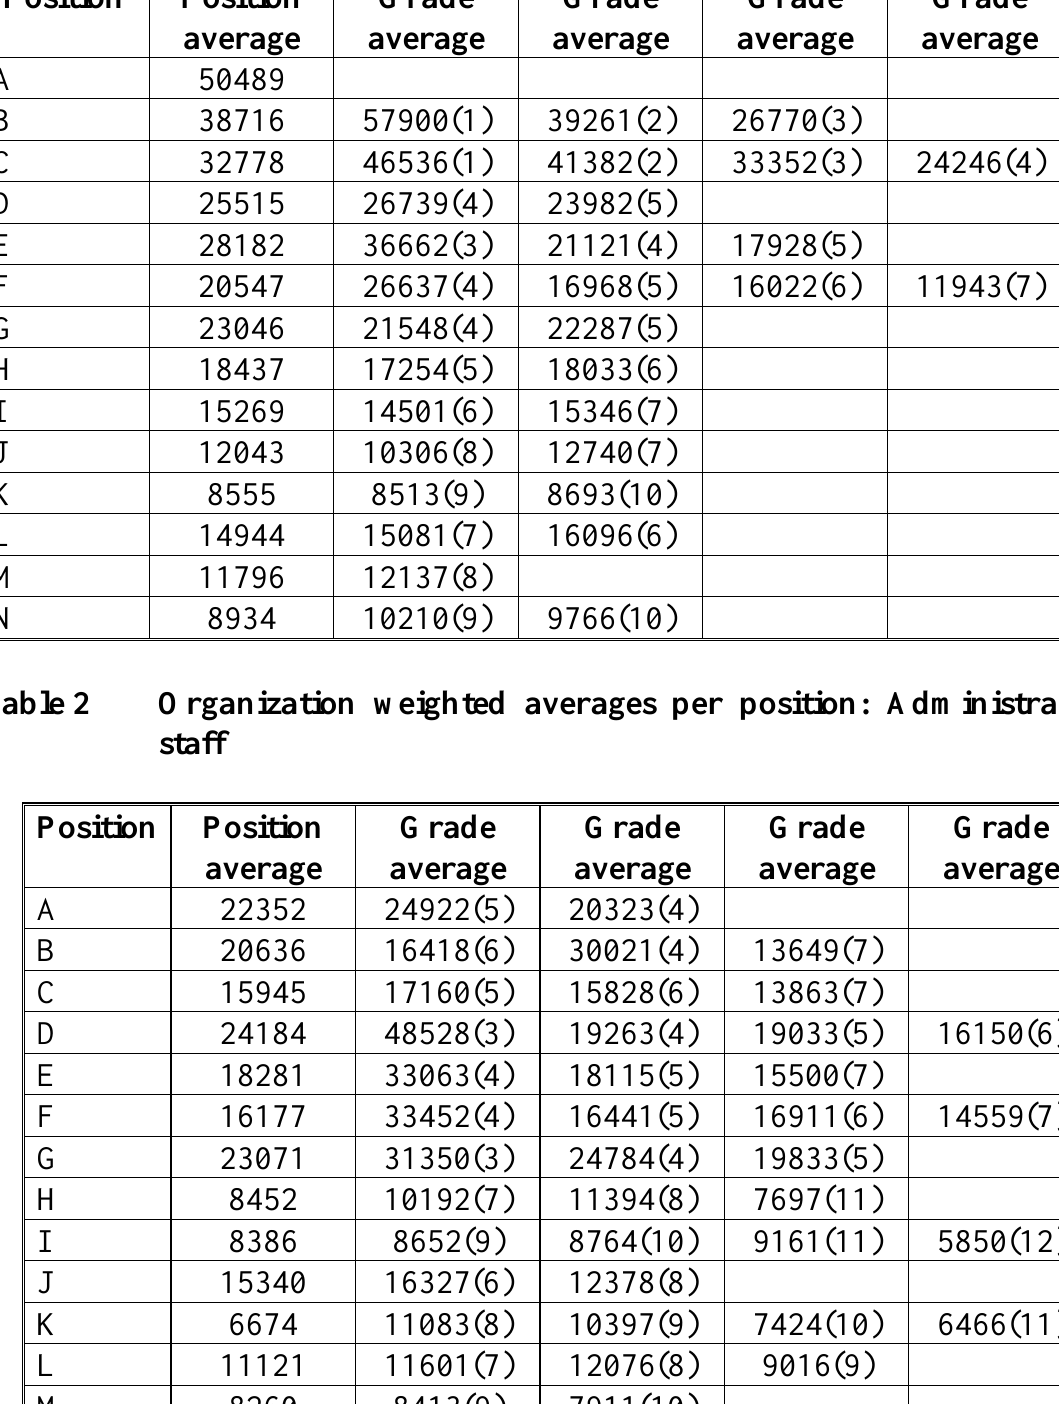
Organization weighted averages per position: Professional staff